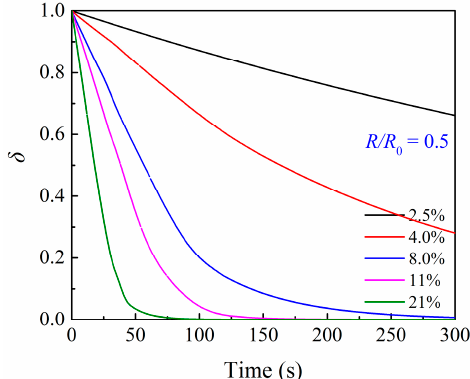
Figure 5. Profile of ratio of the unoccupied area on grain surface at R / R 0 = 0.5 during the oxidation of the particle in Figure 4.